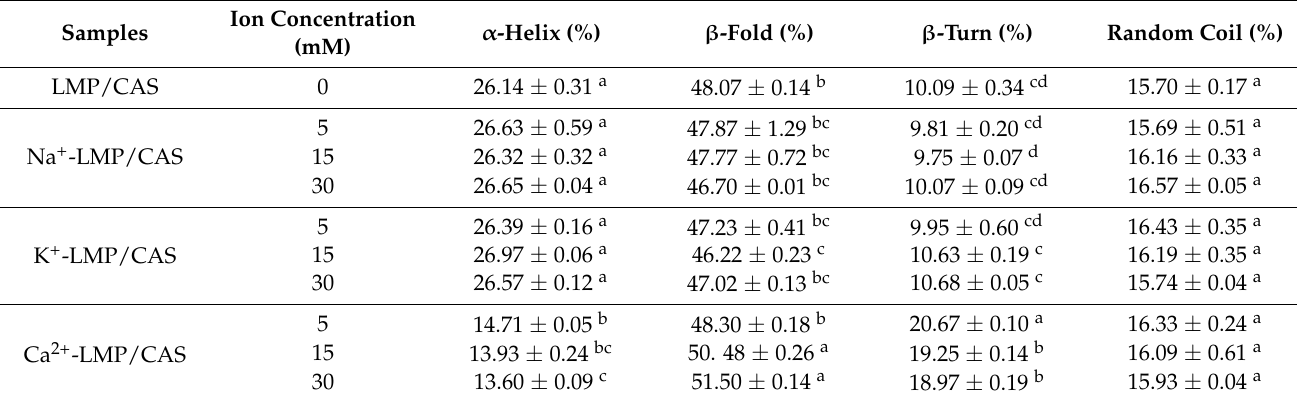
Table 1. The relative contents of four different secondary structures of protein in the low methoxyl pectin/sodium caseinate (LMP/CAS)